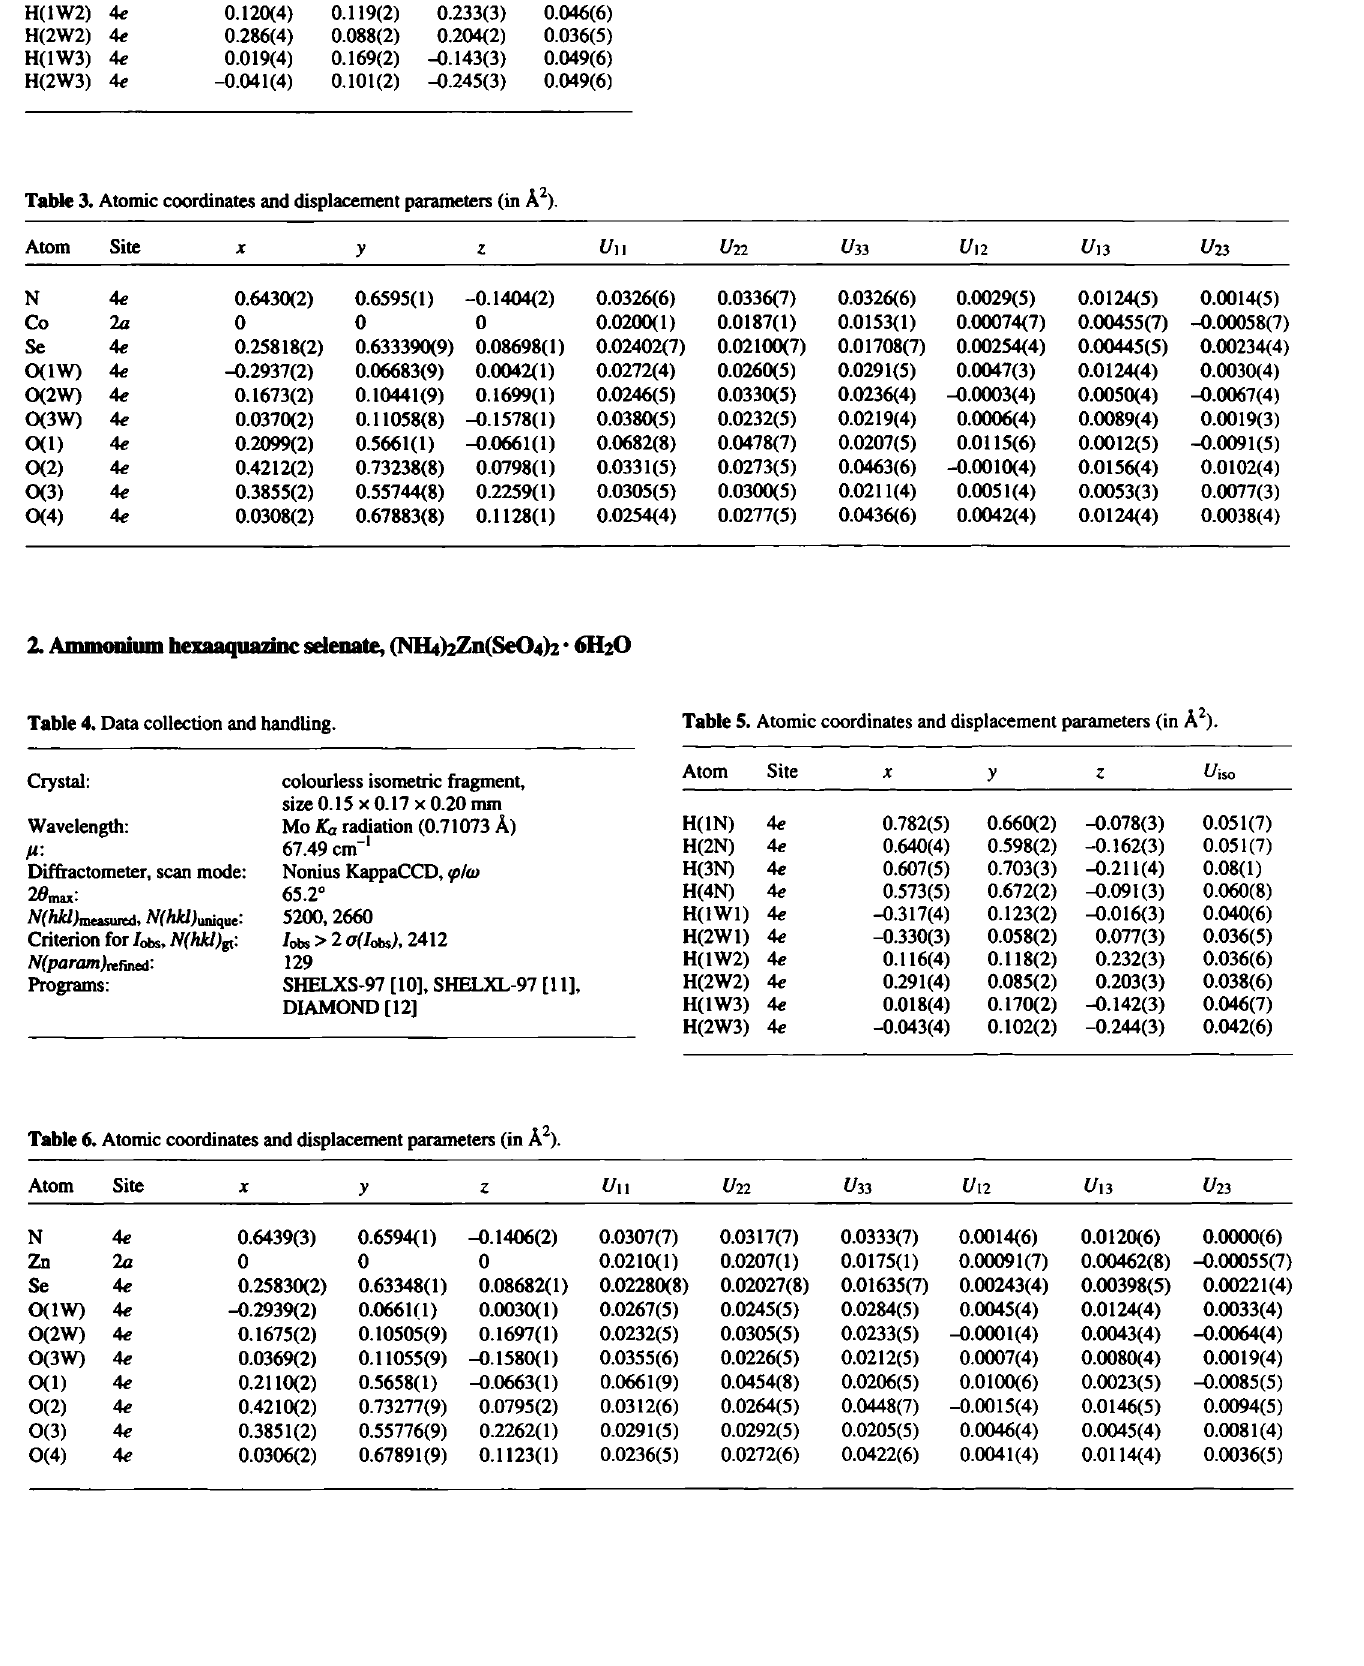
Table 3. Atomic coordinates and displacement parameters (in Â 2 ).